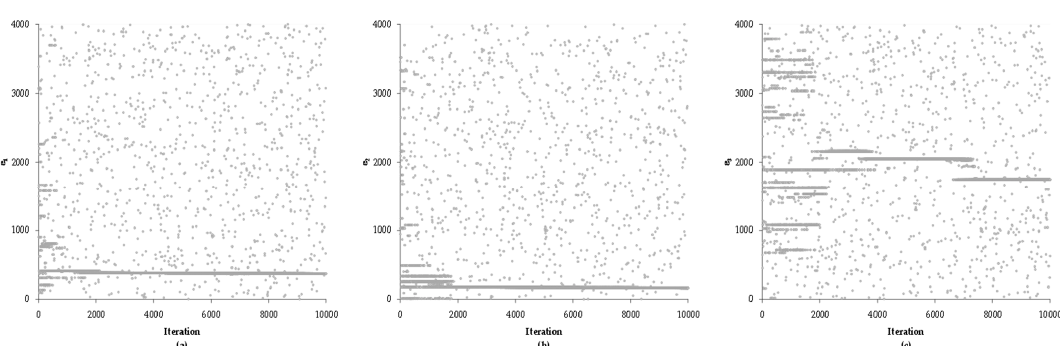
( b ) P 2 ; and ( c ) P 3 for hydrometric station 10031.